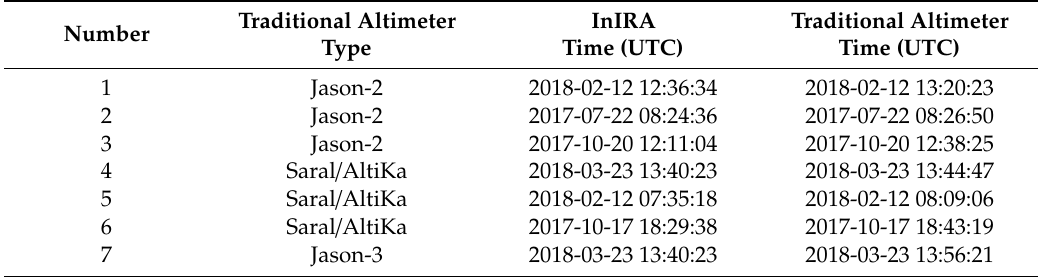
Figure 1. Location of Interferometric Imaging Radar Altimeter (InIRA) and colocated traditional altimeter data. The red circles represent the centre location of InIRA data, while the blue lines represent the ground track of colocated traditional altimeter data. Table 1. Data acquisition time (i.e., start time) for the Interferometric Imaging Radar Altimeter (InIRA) and three types of colocated traditional altimeter data.